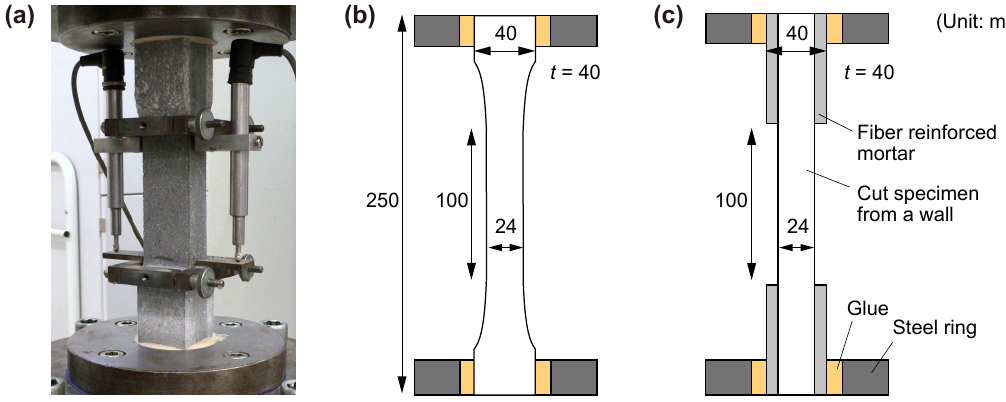
Figure 4. ( a ) setup for uniaxial tension tests; ( b ) schematic view of uniaxial tension tests on mold-cast specimen and ( c ) on printed specimen.